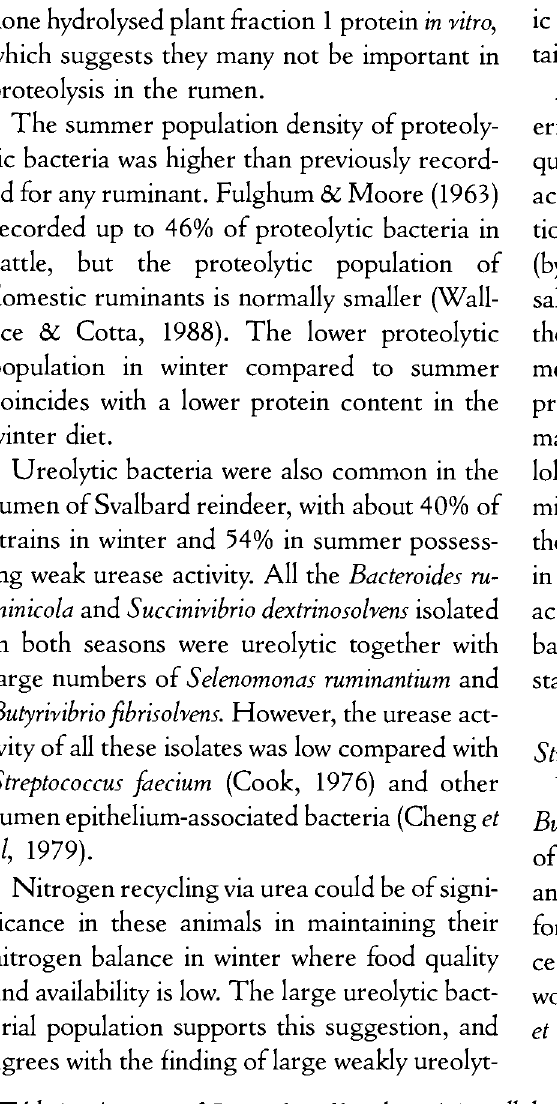
Table 7. Activity of Butyrivibrio fibrisolvens A46 cellulase on polysaccharides